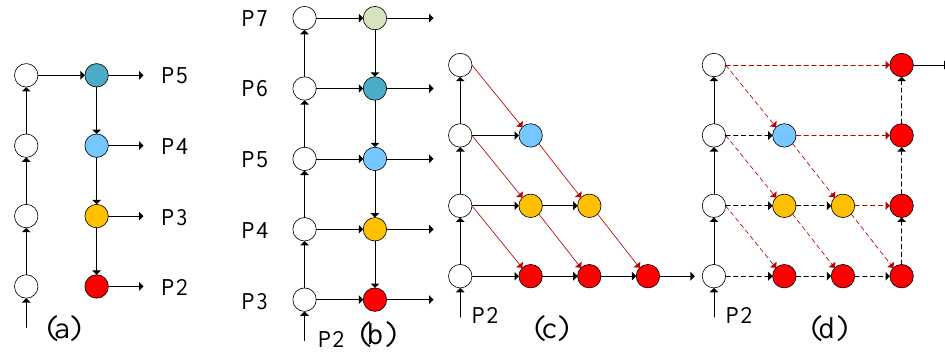
Figure 4. Design of different feature networks. ( a ) ResNet with transpose convolutions as a backbone. ( b ) Feature pyramid network (FPN). ( c ) Deep layer aggregation (DLA) network and ( d ) CenterNet, wich is a modified DLA with more skip